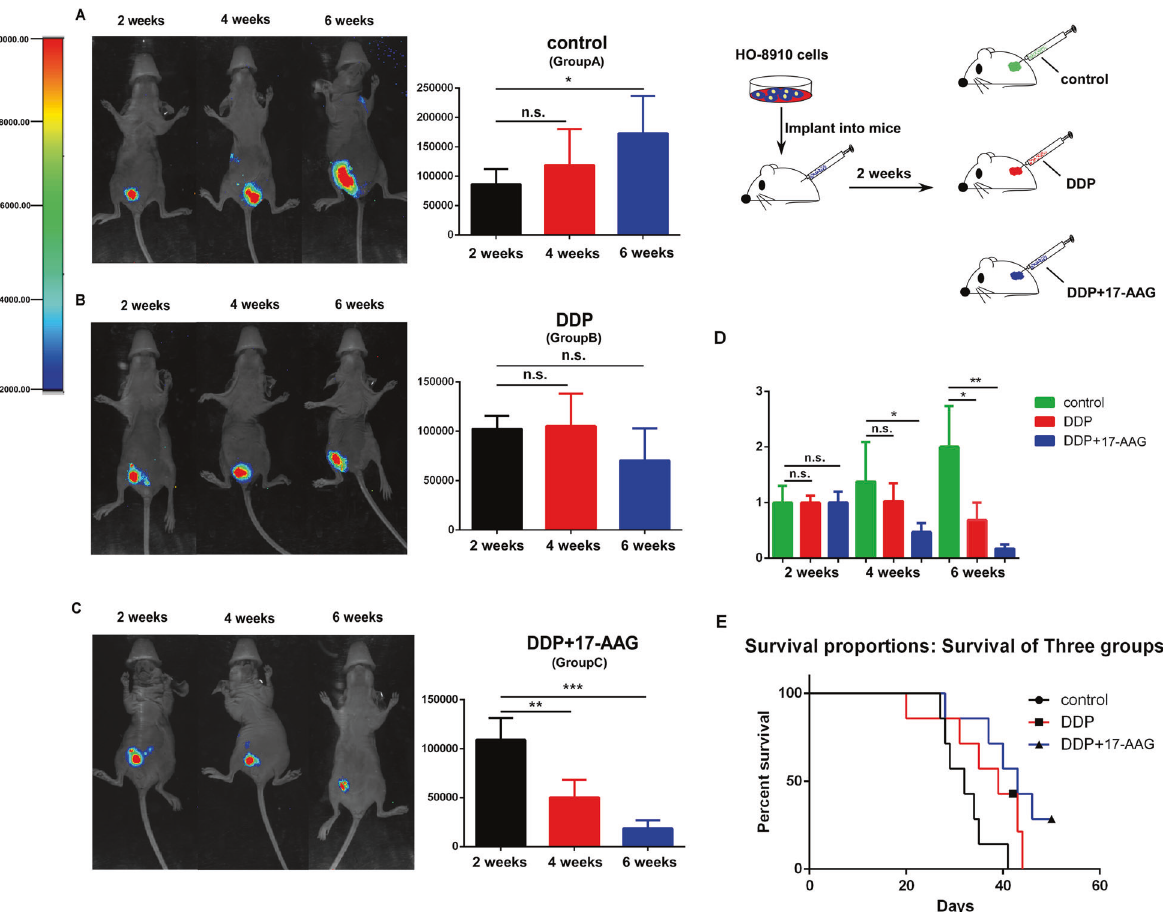
Fig. 6 Combination of 17-AAG and DDP can signi fi cantly inhibit tumor growth of ovarian cancer in vivo and prolong the survival time of mice. A , B, and C : Representative images of animals and quantitative results of luciferase activity at different time points after inoculation with HO-8910 cells (A: group injected with normal saline as control, B group injected with DDP, C group injected with DDP + 17-AAG). Pictures were taken using an IVIS imaging system with i.p. injection of 100 mg/kg of D-luciferin. Color bars represented tumor cell intensity from low (blue) to high (red). D Analysis and quanti fi cations of luciferase activities in all three groups, which were measured every two weeks. E Survival curves of nude mice. All the error bars indicated means ± SD. Statistical signi fi cance was concluded at * p < 0.05; ** p < 0.01; *** p <